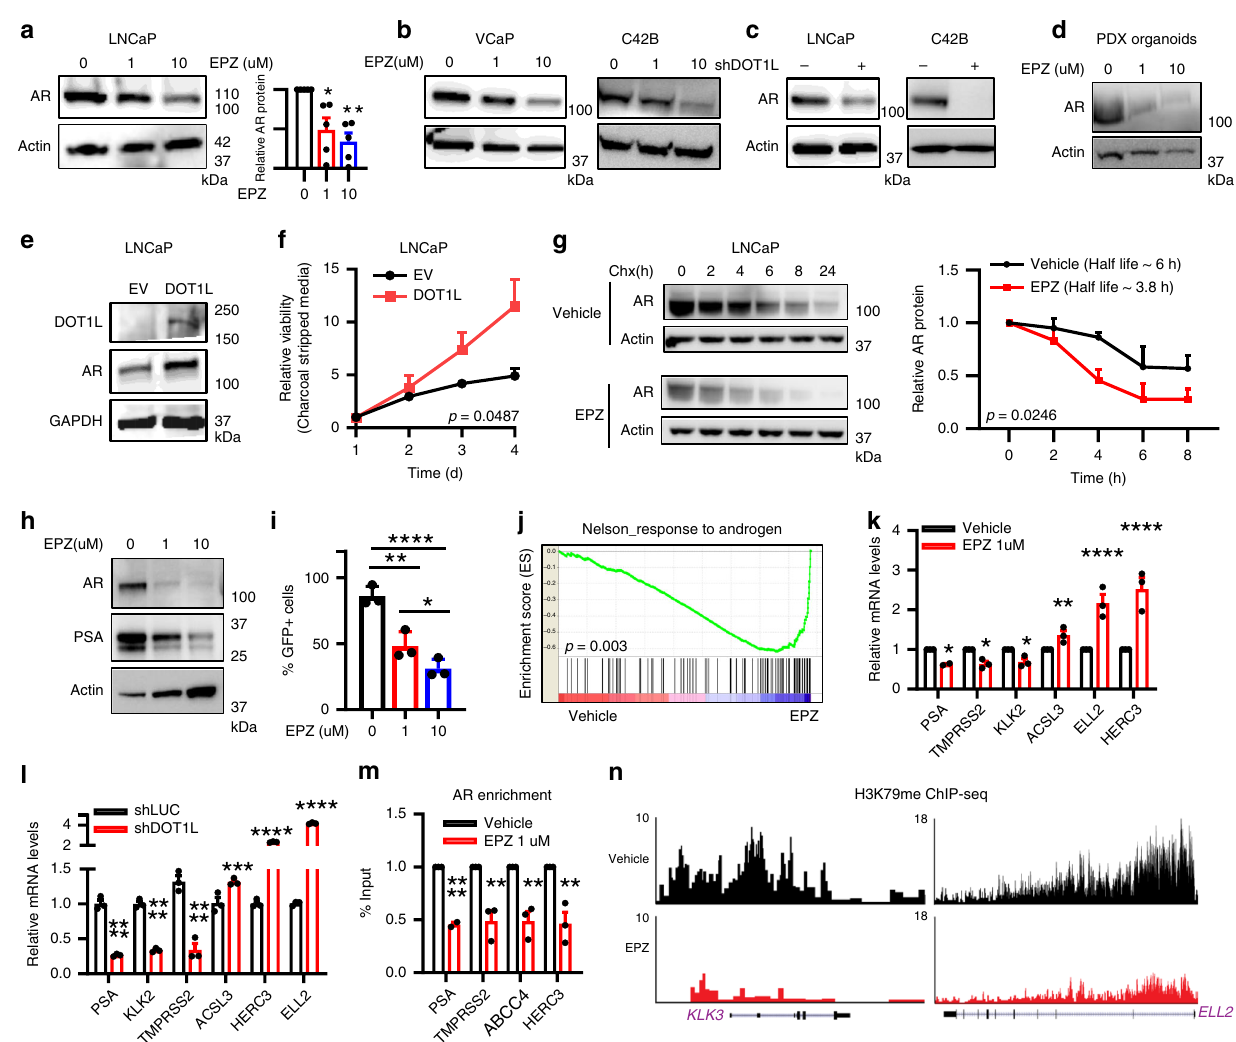
Fig. 3 DOT1L inhibition leads to loss in AR protein levels by decreasing its protein stability. AR protein levels in ( a ) LNCaP cells treated with EPZ followed by quantitation ( n = 5). b AR protein in VCaP and C42B cells after EPZ treatment. c shControl or shDOT1L transfected LNCaP and C42B cells. d PDX organoids treated with EPZ. e AR protein levels in EV or DOT1L overexpressing LNCaP cells. f Proliferation assay of LNCaP cells with and without DOT1L expression in charcoal stripped media measured using MTS assays for 4 days. g AR western analysis after 50 μ g/ml Cycloheximide treatment in LNCaP cells treated with Vehicle or EPZ for 8 days (left). Representative experiment shown. Quantitation of AR protein levels from 3 independent experiments (right). h PSA and AR western blot analysis in LNCaP treated with Vehicle and EPZ for 8 days. Representative image shown. i Percentage of RFP + GFP + cells counted by Flow cytometry after 8 days of Vehicle or EPZ treatment in LNCaP cells transfected with ARE-GFP reporter construct. j GSEA plot of Nelson_Response_to_Androgen geneset enriched in LNCaP cells treated with 1 μ M EPZ for 8 days compared to Vehicle treatment. mRNA expression of 6 AR target genes measured by qRT-PCR in LNCaP cells after 8 days of ( k ) 1 μ M EPZ treatment and ( l ) transduction with shDOT1L or shControl lentivirus. m Relative enrichment of AR at 4 target genes measured by ChIP followed by qPCR in LNCaP cells treated with Vehicle or 1 μ M EPZ for 8 days. n ChIP-seq plots of H3K79me2 at two AR target genes in LNCaP cells treated with Vehicle or 1 μ M EPZ. Statistical tests: p value determined by two-tailed t test ( a , f – i , k – m ) corrected for multiple comparisons in ( k – m ). n = 3 independent experiments ( b , c , f , h – m ). FDR < 25% ( j ). Error bars represent S.E.M. * p < 0.05; ** p < 0.01; *** p < 0.001; **** p <